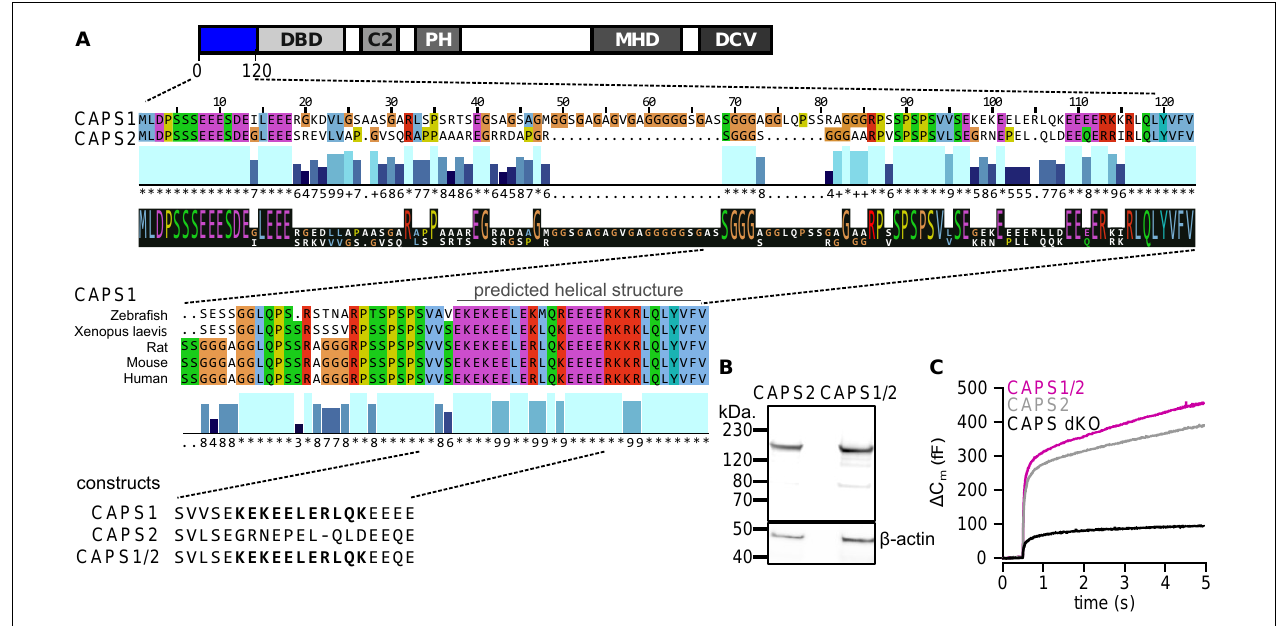
FIGURE 2 | Identification of a distinct predicted coiled-coil structure in the N-terminus of CAPS1. (A) CAPS domain structure with N-terminal sequence alignment of CAPS1 and CAPS2 showing a unique CAPS1 sequence (upper panel), which is aligned with the same sequence in other species (lower panel). Conservation and consensus sequence are automatically calculated by jalview and displayed below the sequence alignment. Conservation is visualized as blue bars. Their tone and height indicate the score for each column. The numbers reflect the conservation of physico-chemical properties in the alignment: identities score highest, and the next most conserved group include substitutions of an amino acid to an other lying in the same physico-chemical class. Conserved columns are indicated by an * (score of 11 with default amino acid property grouping), and columns with mutations where all properties are conserved are marked with a + (score of 10, indicating all properties are conserved). The consensus sequence logo indicates with its size the relative number of amino acids per column. (B) Western blot analysis of CAPS2 and CAPS1/2 chimera protein expression. Chromaffin cells transfected with CAPS2b-HA or CAPS1/2-HA were lysed and blotted with an anti-HA antibody. β -actin was used as a loading control. (C) Averaged membrane capacitance measurements of CAPS dKO mouse chromaffin cells transfected with CAPS2b (light gray, n = 20) or CAPS1/2 (magenta, n = 22) compared to non-transfected controls (black, n = 15); N experiment =